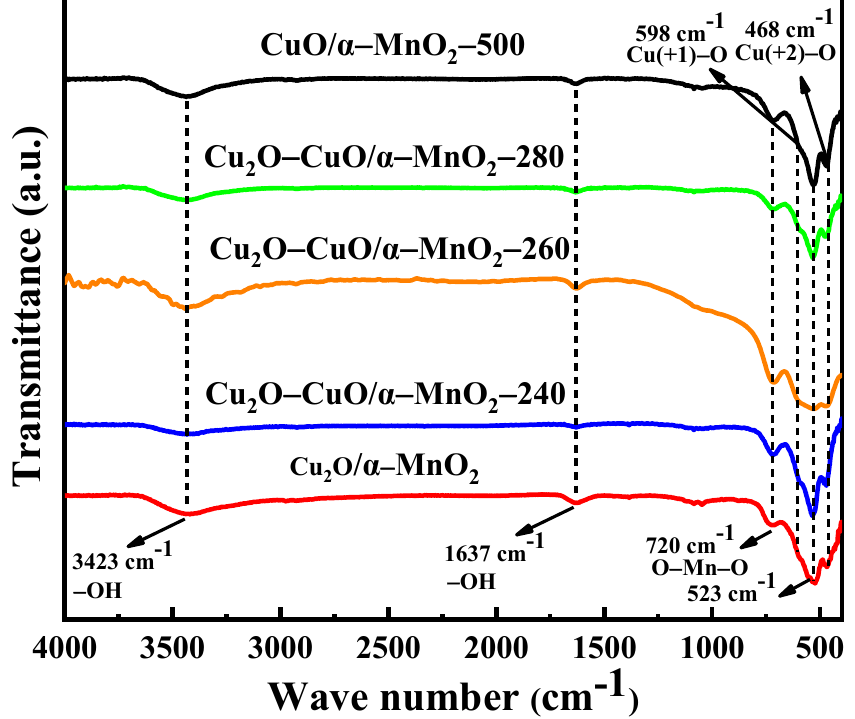
Figure 10. FTIR characterization for the as-prepared Cu 2 O/ α -MnO 2 , Cu 2 O-CuO/ α -MnO 2 -T, and CuO/ α -MnO 2 -500 catalysts.